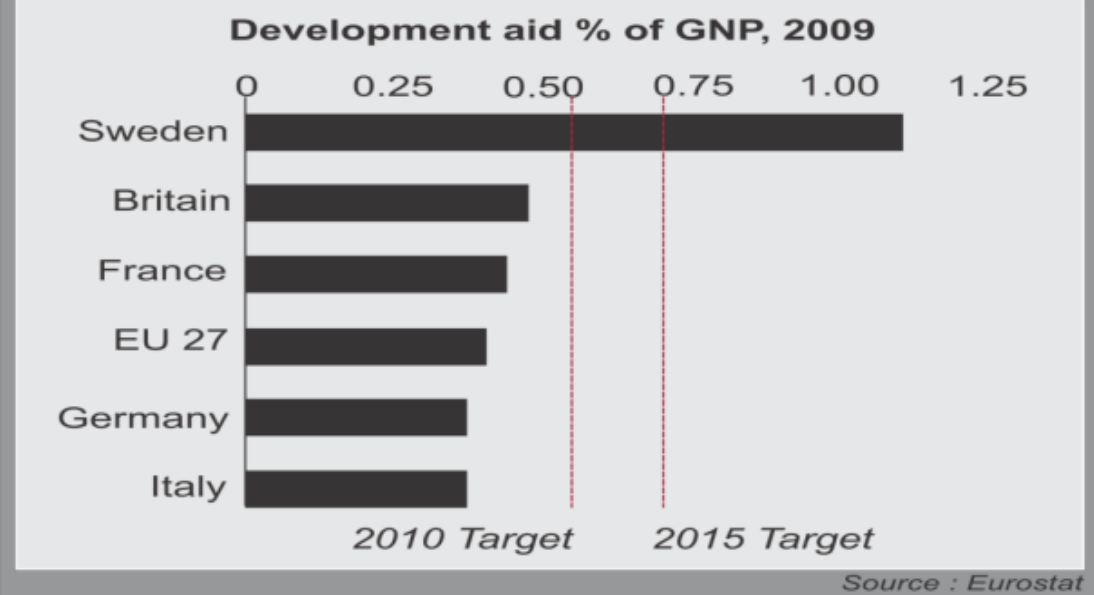
Figure 2: The growth of development aid to sub-Saharan Africa. Source: Economist print edition